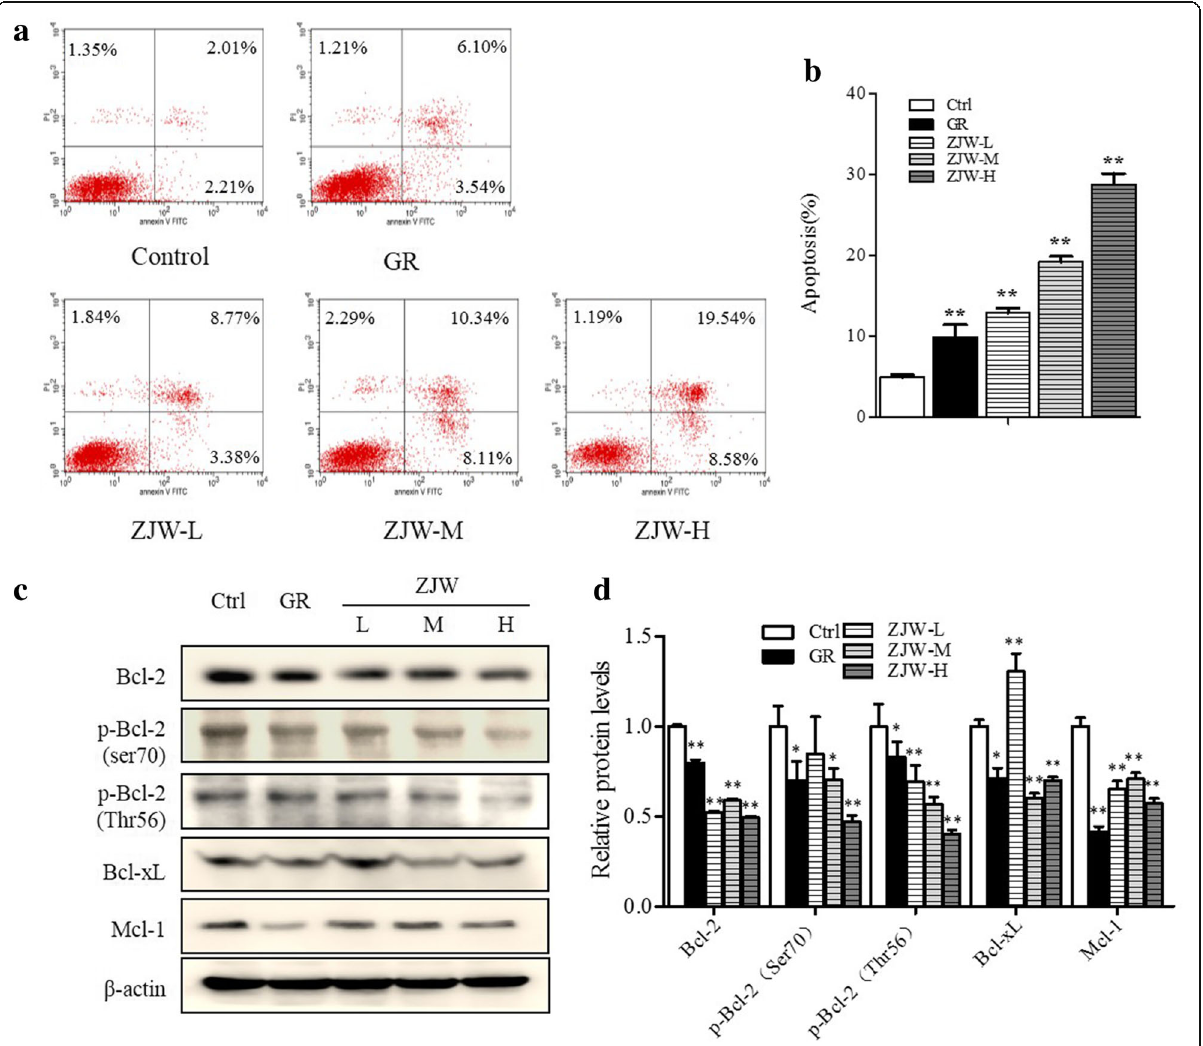
Fig. 3 Effect of the ZJW extracts treatment on cell apoptosis. a Flow cytometric analysis of apoptosis of SW403 cell under ZJW-L, ZJW-M, ZJW-H, or GR (5 μ mol/L) treatment conditions, compared to the control without any treatment for 24 h. b The percentage of cells underwent apoptosis. c Representative western blots of Bcl-2, p-Bcl2 (Ser70), p-Bcl-2 (Thr56), Bcl-xL and Mcl-1 in SW403 cells treated with GR (5 μ mol/L), ZJW-L, ZJW-M or ZJW-H. d The corresponding semi-quantification data of ( c ). All values are shown as mean ± SD of three separate experiments, and significant values are indicated with asterisks (* P < 0.05, ** P < 0.01 vs.